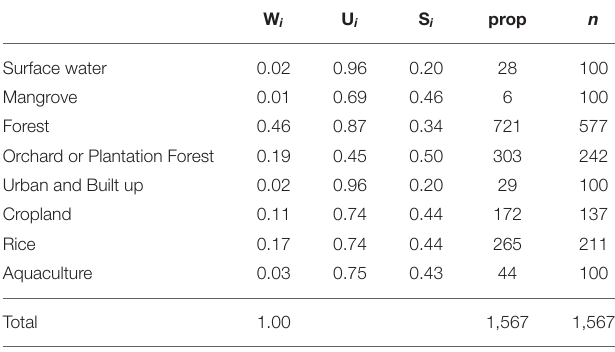
TABLE 1 | Sampling strata for the different land cover classes.